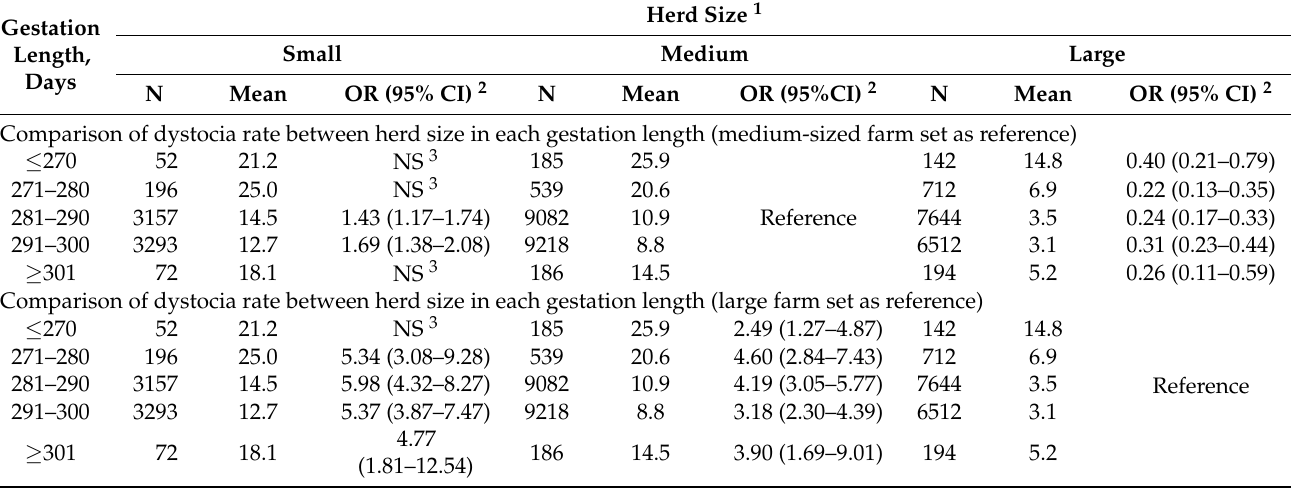
Table 2. Comparison of dystocia rate between herd sizes in each gestation length and comparison of dystocia rate between each gestation length in herd size